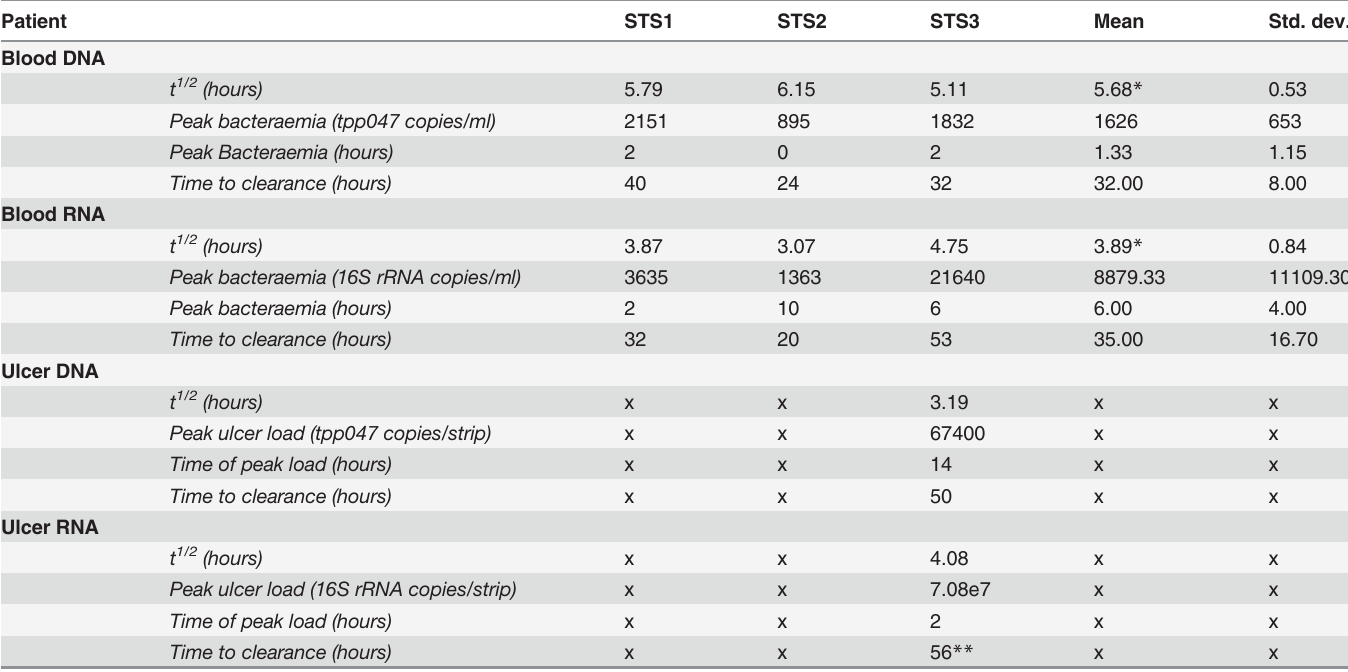
Table 2. Measurement of T. pallidum clearance post-treatment. Patient STS1 STS2 STS3 Blood DNA